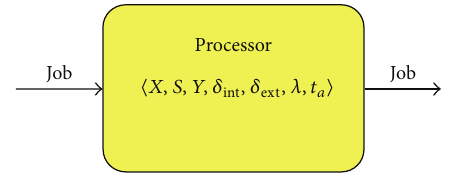
Figure 1: DEVS model of a